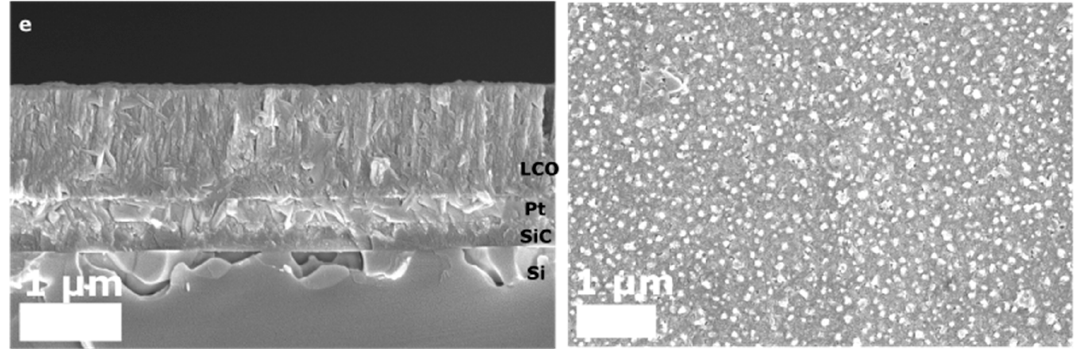
Figure 4. SEM images of LiCoO 2 thin films on Pt/SiC/Si: ( a , b ) as-deposited and nonannealed; ( c , d ) cross-sectional and surfaceviewsof film annealed at 550 °C with a ramp rate of 30 °C min − 1 and annealing time for 1 h 20 min in Ar; ( e , f ) cross-sectional and surface morphology of LCO/Pt/SiC/Si at 650 °C with a ramp rate of 30 °C min − 1 and annealed for 1 h 20 min in Ar atmosphere.